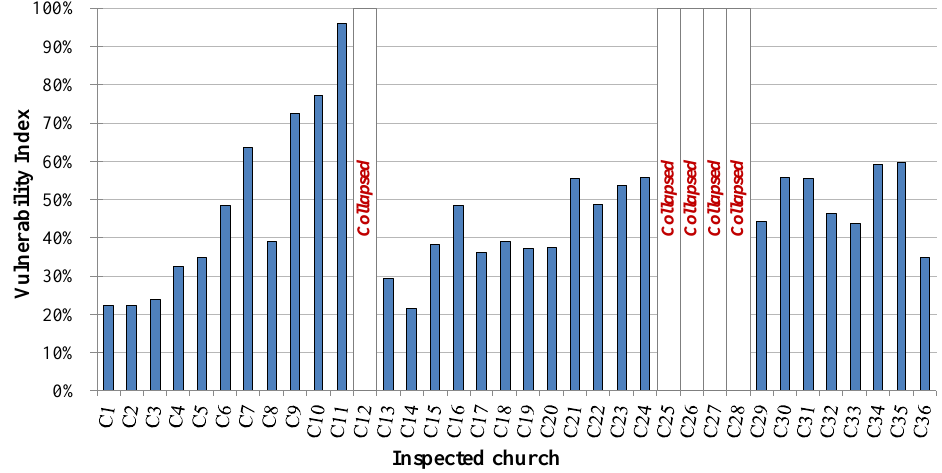
Figure 9. Vulnerability index evaluated for the inspected churches according to the LV1 approach.